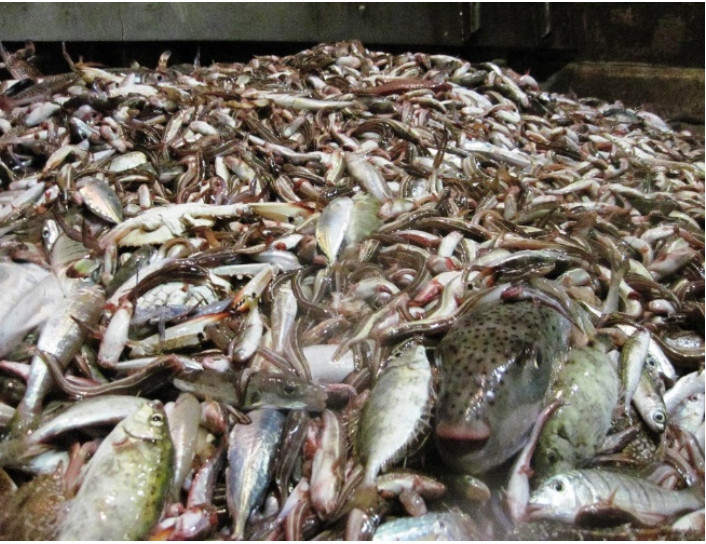
Figure 20. A typical catch of the trawl fishery in the Mediterranean coast of Israel in recent years, with many venomous striped eel catfish, rabbitfish, and highly poisonous pufferfishes (photograph by Dor